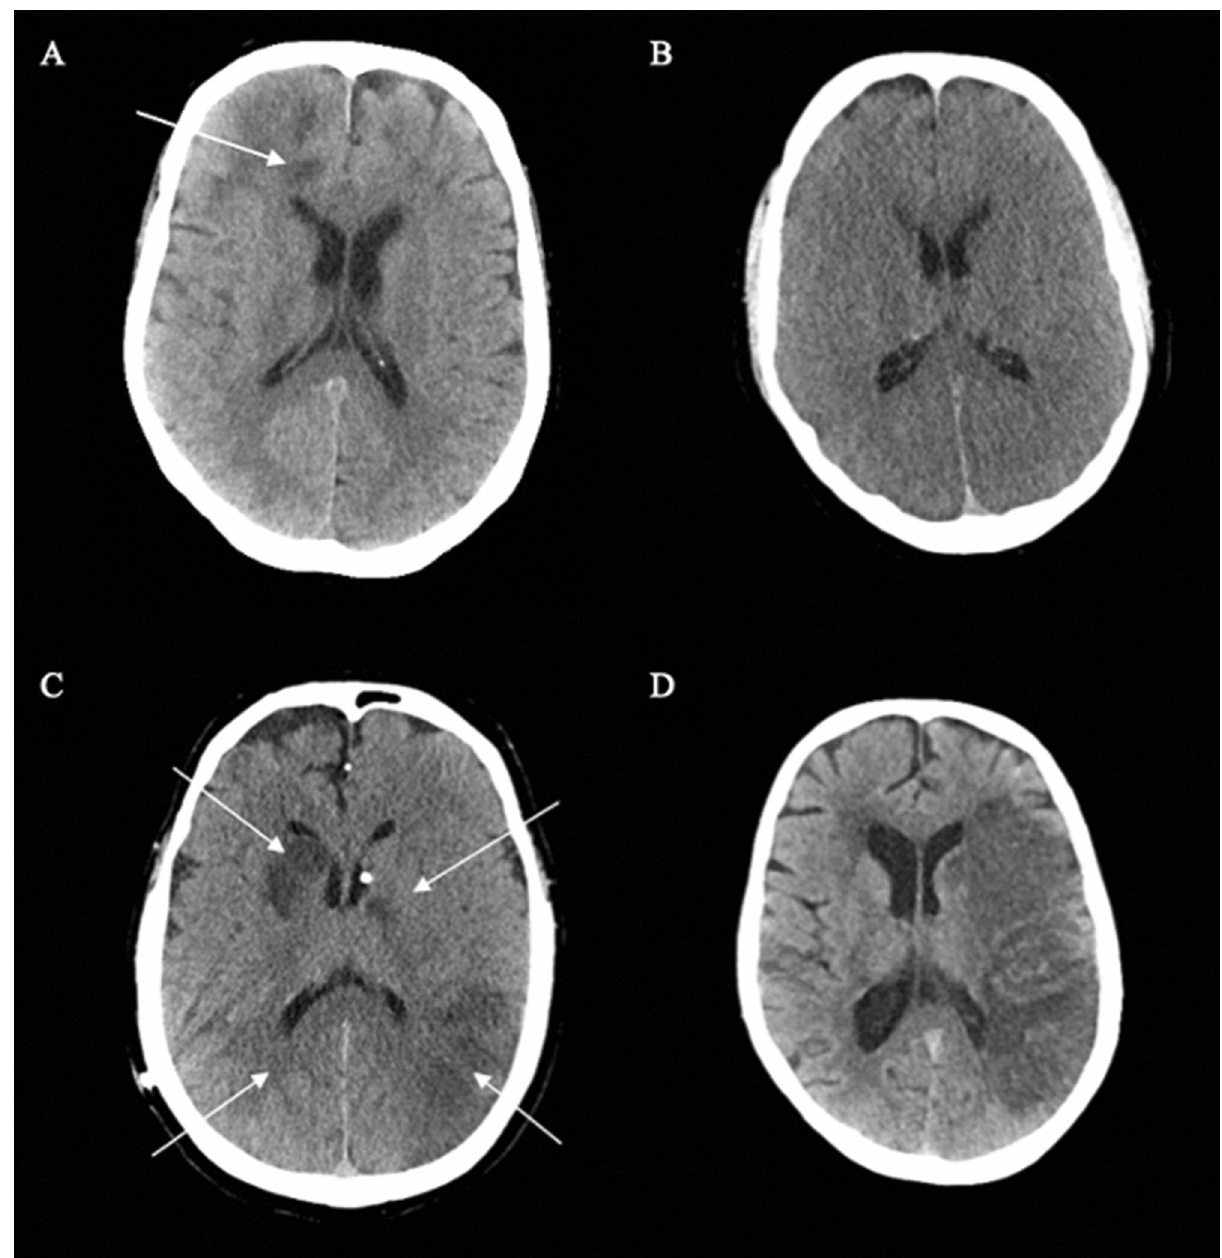
Figure 2. Four different examples of brain infarction during treatment on extracorporeal membrane oxygenation. Each arrow indicates a brain infarction that was diagnosed during ECMO treatment. ( A ) Watershed infarction; ( B ) hypoxic brain injury; ( C ) multiple ischemic cerebrovascular lesions; ( D ) middle cerebral artery